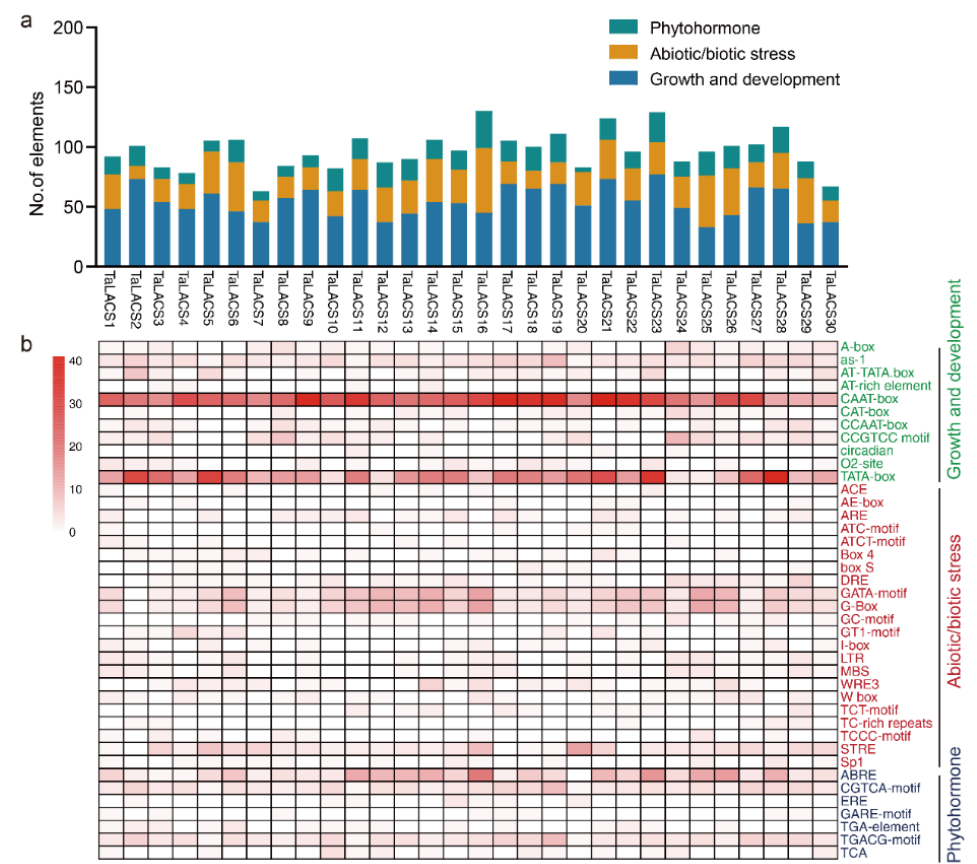
Figure 4. Cis -acting elements in the promoters of wheat TaLACS genes. ( a ) Number of elements assigned to biotic/abiotic stress, growth and development, and phytohormone responses for each TaLACS . ( b ) Cis -acting elements in the promoters of TaLACS genes in wheat. The different shades of red represent the number of cis -acting elements.